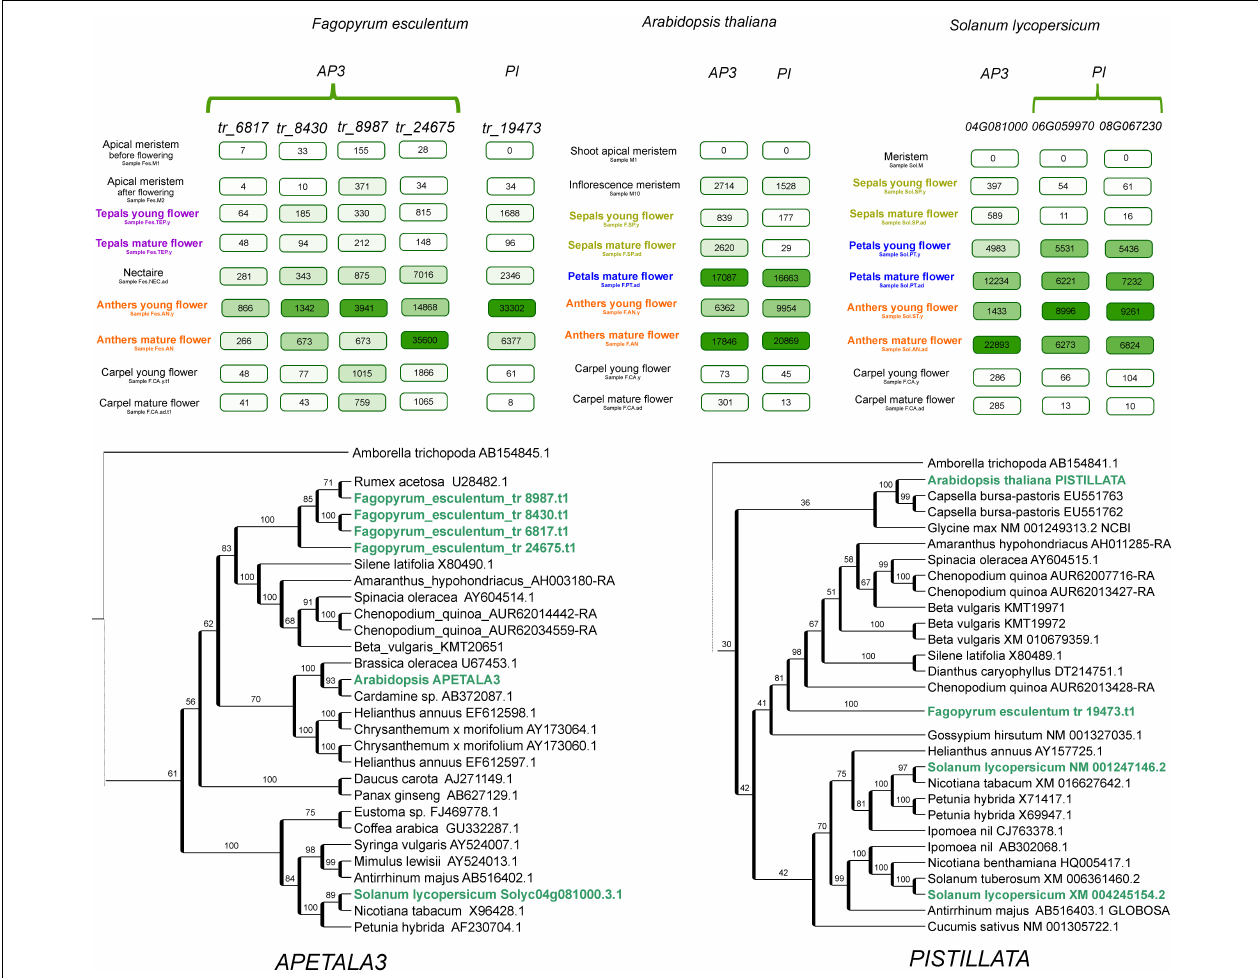
FIGURE 5 | Phylogeny and expression patterns of the orthologs of the B-class genes APETALA3 and PISTILLATA in Arabidopsis , buckwheat and tomato, with a focus on floral organs. Numbers in boxes denote normalized read counts. Color saturation is proportional to the expression level (each has its own scale). Selected samples are represented; complete profiles are available at